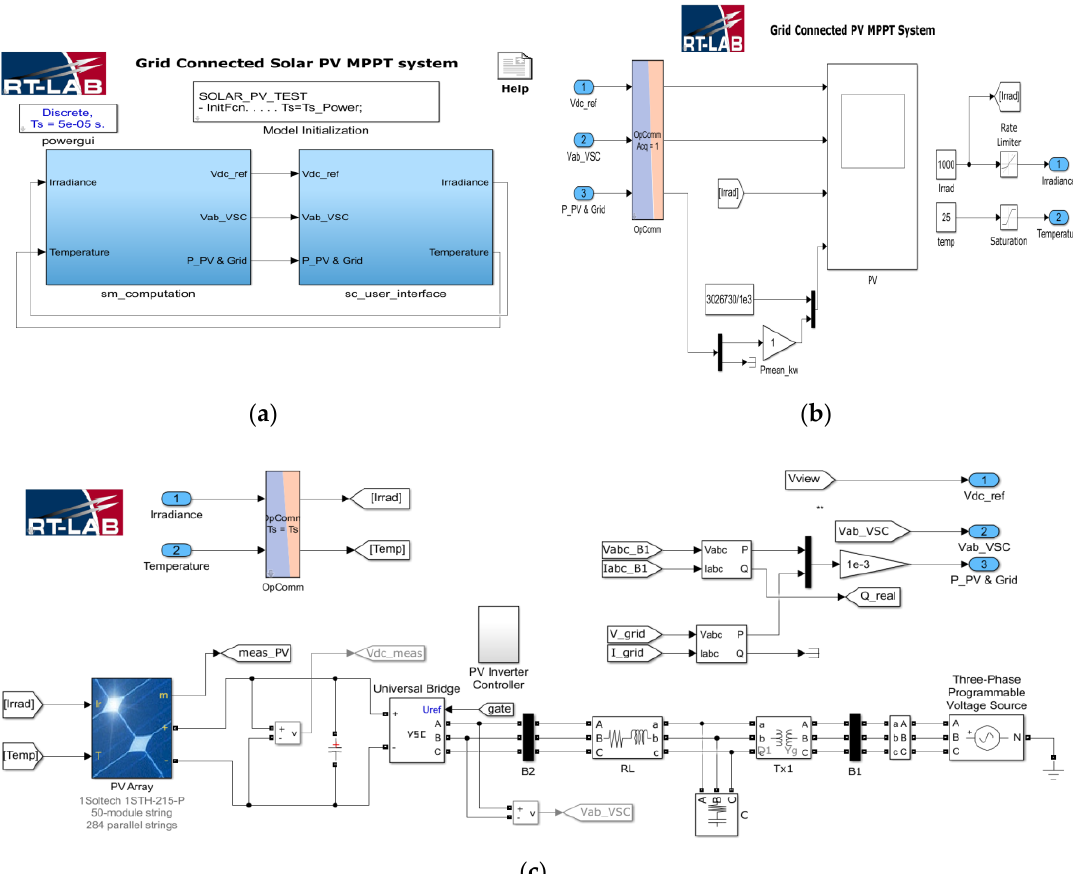
Figure 8. Simulink model for real-time machine-in-loop (MIL) simulation in OPAL-RT: ( a ) RTLAB-based Simulink interface; ( b ) sc_user_interface block; ( c ) sm_computation